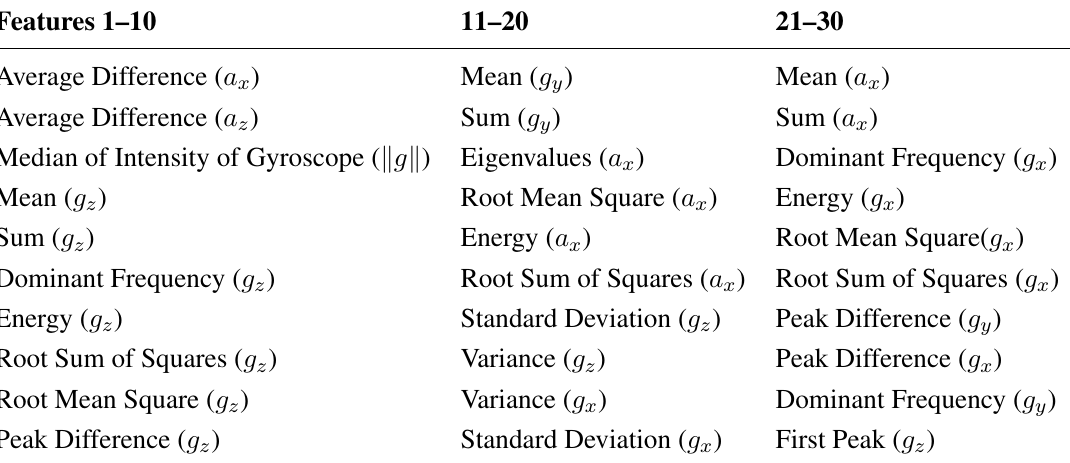
Table 3. Top 30 features selected for the smartwatch at 10 Hz (and the axis).